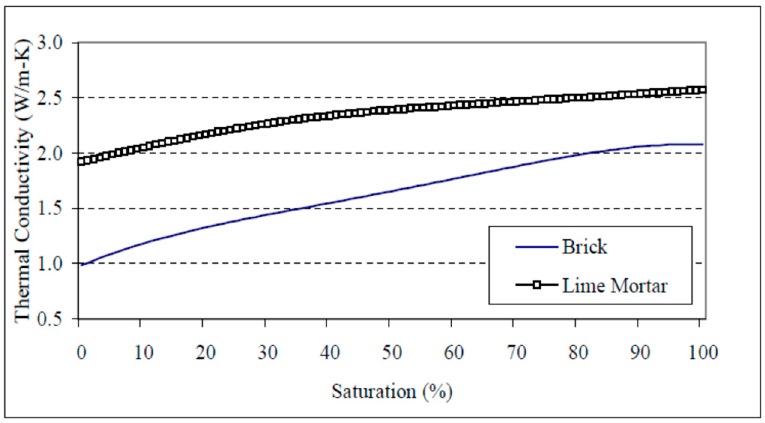
Figure 1. Modelled thermal conductivity [31].